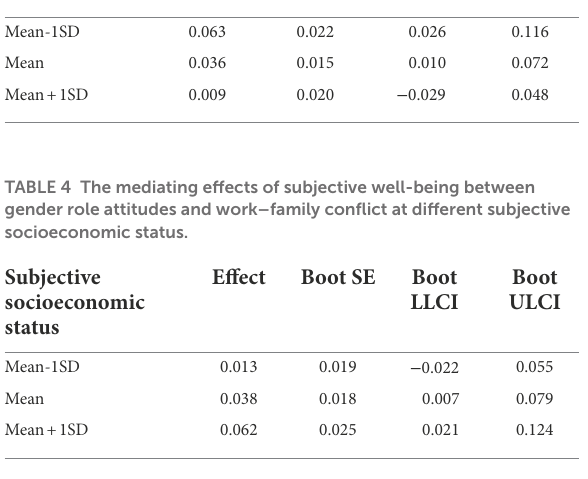
TABLE 3 The mediating effect of parental sacrifice between gender role attitudes and work–family conflict at different education levels. Education levels